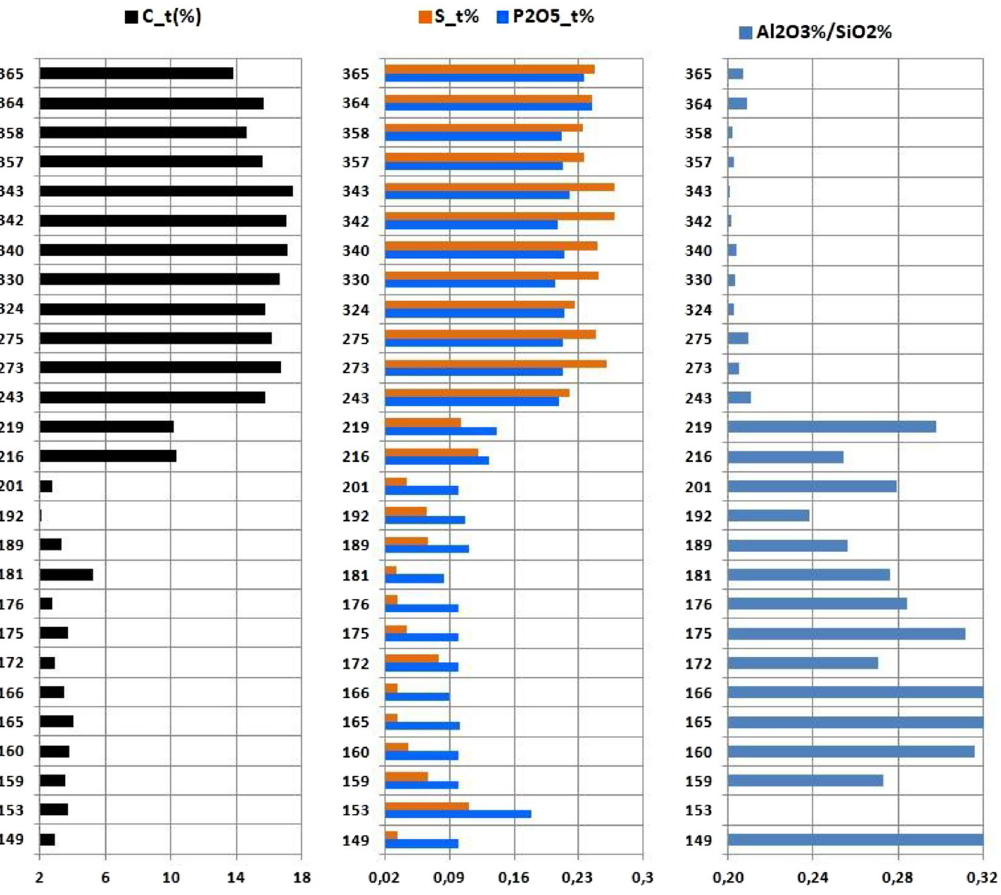
Figure 10. Distribution of C tot , S, and P 2 O 5 contents and Al 2 O 3 /SiO 2 ratios in cryoconite. The vertical axis shows the absolute altitude of the sampling spot, and the horizontal axis shows the content of chemical components in weight %.